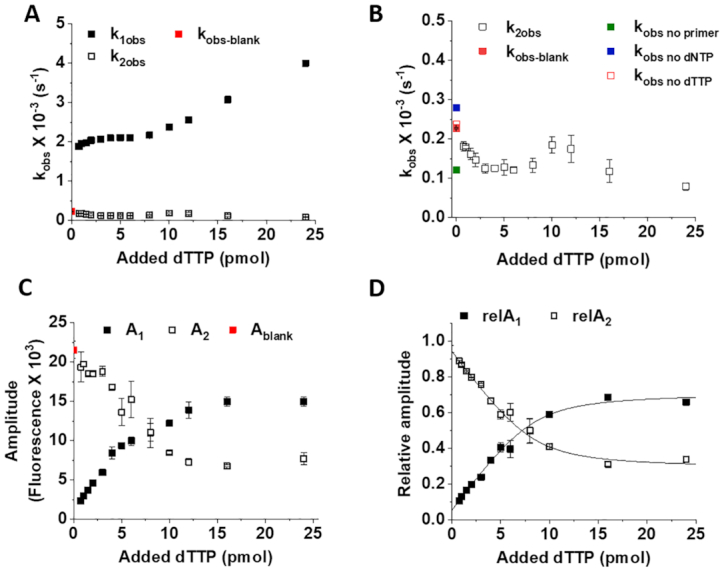
Background exonuclease activity of AmpliTaq Gold™ polymerase competes with specific dNTP incorporation in a concentration dependent manner. Concentration is understood to be pmol dTTP in constant reaction volume. (A) Concentration dependence of the observed rate constants of the two kinetic phases in the assay (k1obs and k2obs, respectively). (B) Concentration dependence of the observed rate constant of the slower phase (k2obs). The observed rate constants of the background reaction presented in Figure 2A are also shown as kobs no primer, kobs no dNTP, kobs no dTTP (blank). (C) Concentration dependence of the amplitudes of the two phases (A1 and A2, respectively). (D) Concentration dependence of the relative amplitudes of the two phases (relA1 and relA2, respectively). The amplitudes were normalized compared to the total amplitude of the reaction (A1 + A2). The relative amplitudes could be fitted with quadratic binding equation (Equation 3) yielding the following parameters: Aquad = 0.660 ± 0.036, S = 0.054 ± 0.002, c = 8.345 ± 0.453, Kapp = 0.741 ± 0.290 for relA1, and Aquad = −0.660 ± 0.036, S = 0.946 ± 0.002, c = 8.345±0.453, Kapp = 0.741 ± 0.290 for relA2. Data represent the average and SD of two technical parallels for each panel.